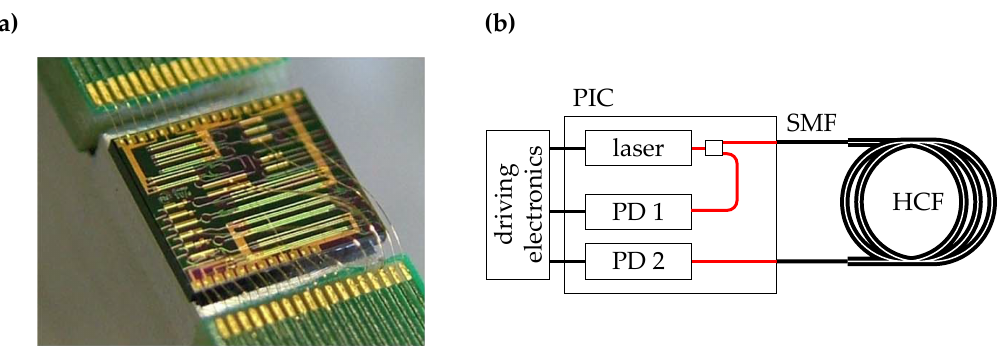
Figure 1. ( a ) Photonic Integrated Circuit (PIC) containing six tunable laser sources. The chip has been attached to a submount and the electrical contacts have been wire-bonded to a printed circuit board. Fibers would approach the light output ports from the left or right side of the chip. These connections can be fixed, e.g., with glue, to provide a packaged device. c (cid:13) 2015 IEEE. Reprinted, with permission, from Latkowski et al.; Novel Widely Tunable Monolithically Integrated Laser Source. IEEE Photonics Journal 2015 , 7 , 1–9 [6]; ( b ) Schematic for a compact gas sensor using PICs and a hollow-core fibre (HCF). A HCF can be spliced to lensed or tapered single-mode fibres (SMF), which are typically used for fibre chip coupling on indium phosphide (InP) based, butt coupled PICs. A PIC can contain light sources as well as photodectors (PD 1 and PD